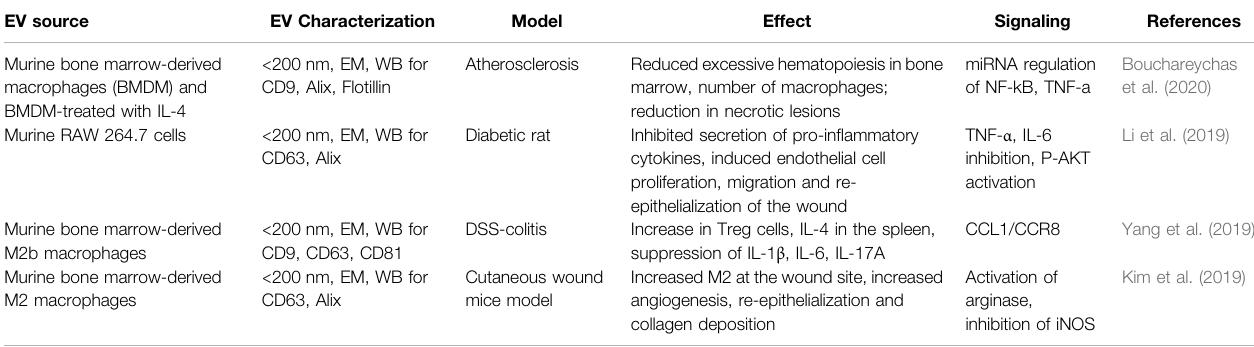
TABLE 3 | The biological effect of macrophage-EVs on organ repair in various non-radiation injury